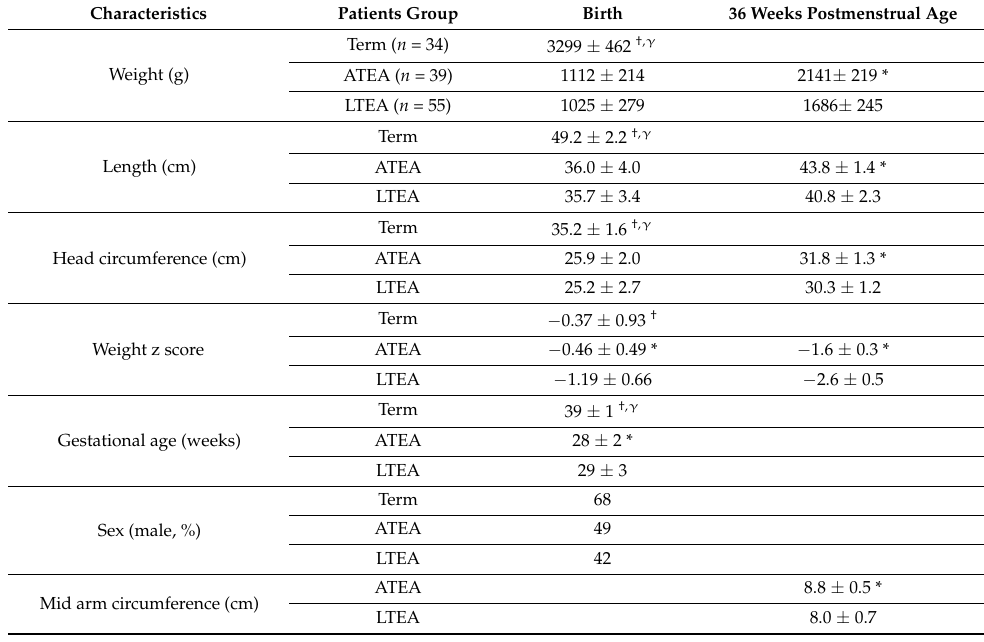
Table 1. Anthropometric data at birth and 36 weeks postmenstrual